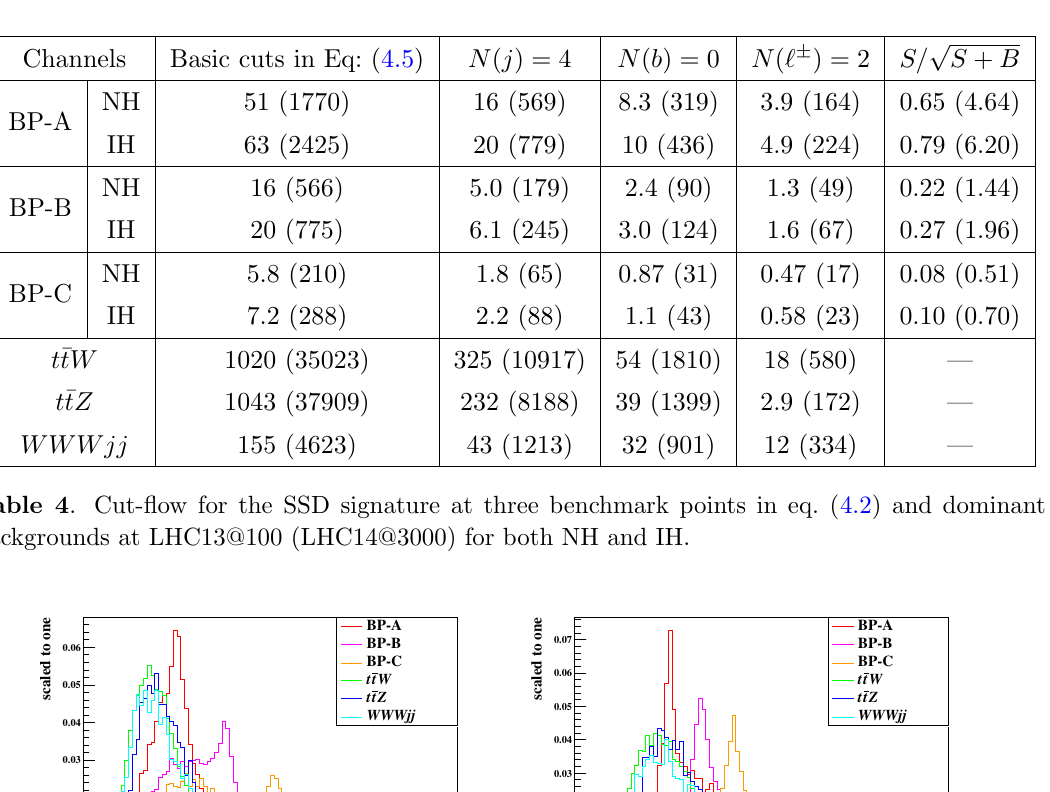
( M ) at 13 TeV jj‘ (cid:6) jj‘ (cid:6) ‘ (cid:6)